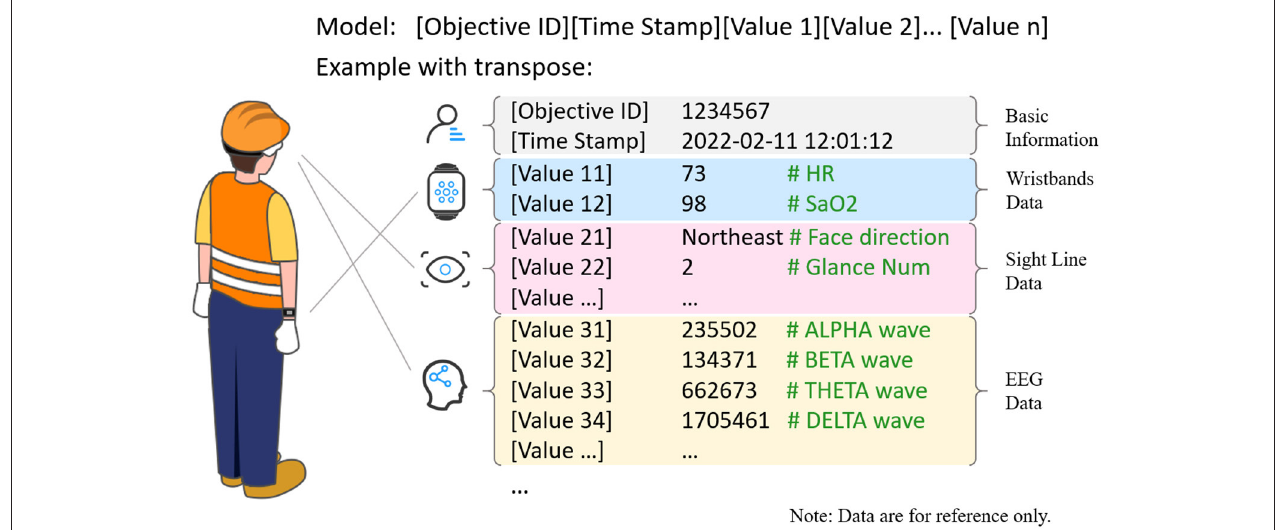
FIGURE 7 | The recommendation model and example.